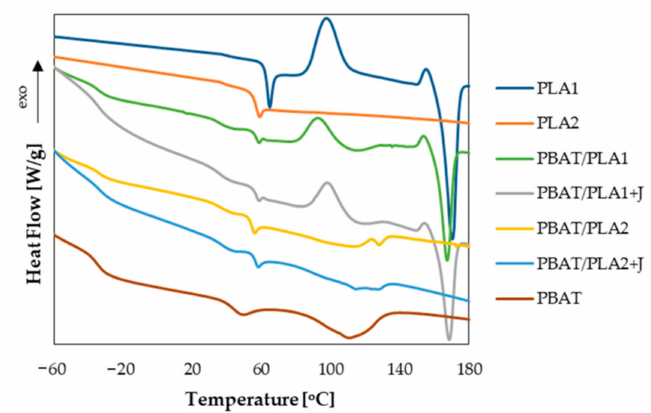
Figure 5. Thermograms of the film related to the first heating scan. Table 2. The main thermal properties of the films related to the first heating scan: Glass